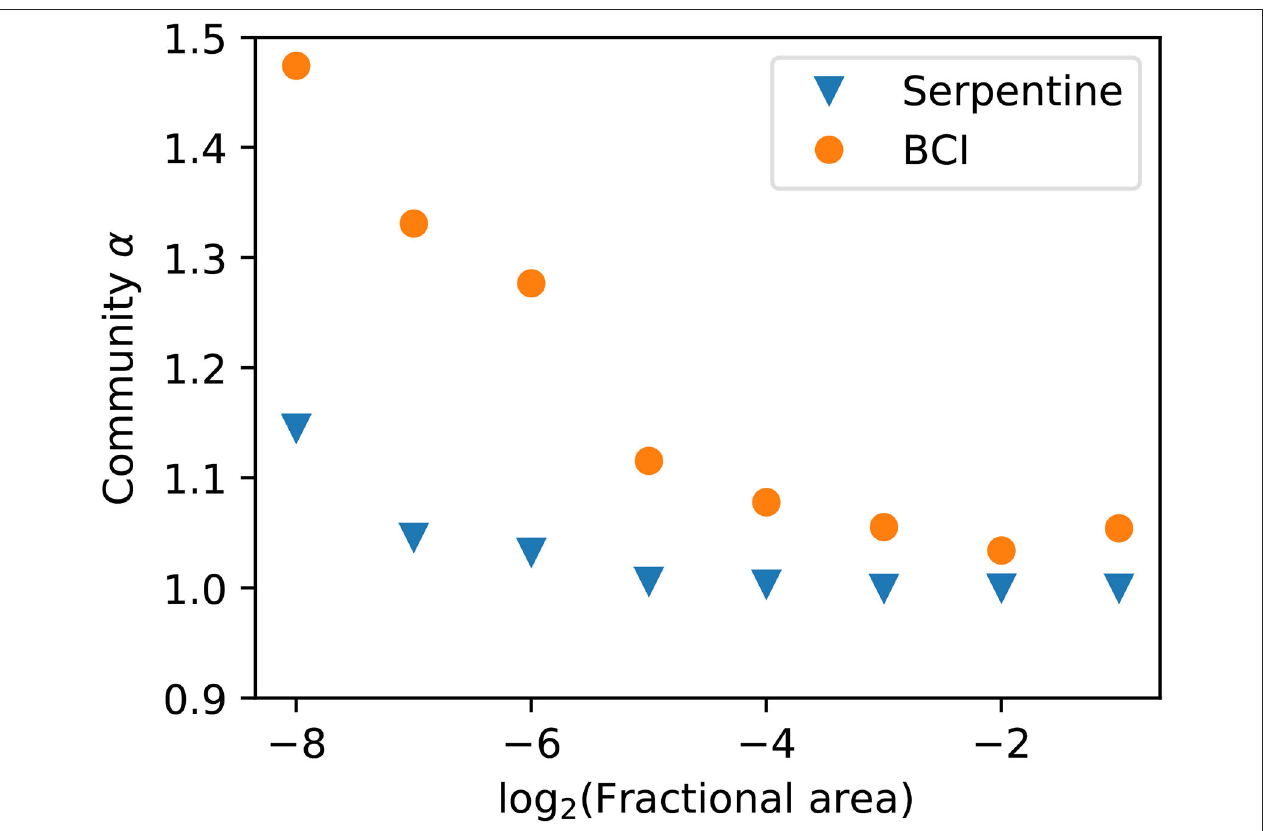
FIGURE 4 | Community α scaling with area for species with abundance n 0 > 128. The density dependence again increases at smaller scales and the trend is similar to the single species analysis. The serpentine dataset has 36,783 individuals and the BCI dataset has 15,960 individuals.